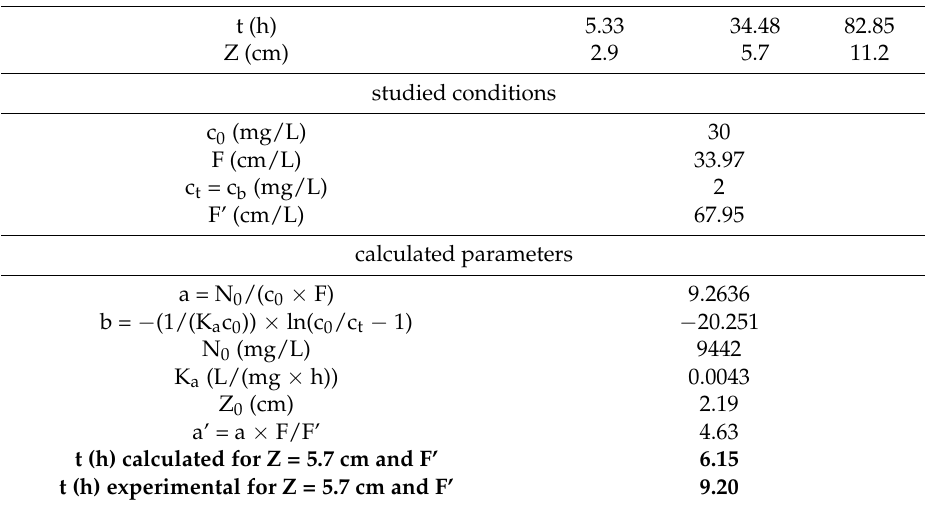
Table 1. The values used for determining the parameters of Bed Depth Service Time (BDST) model and values calculated on their basis, t—time of obtaining in the effluent concentration c t , Z—bed height, c 0 —initial concentration of zinc(II) ions, F, F’—linear flow rate, c B —breakthrough concentration, a, a’—slope of the curve, b—intercept of the curve, N 0 —adsorption capacity, K a —rate constant in BDST model, Z 0 —minimum bed